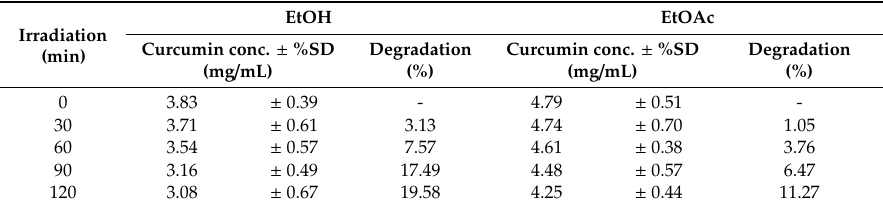
Table 3. Curcuminoid extract US degradation